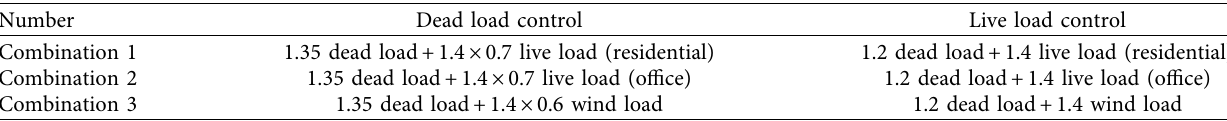
Table 7: Load combinations.